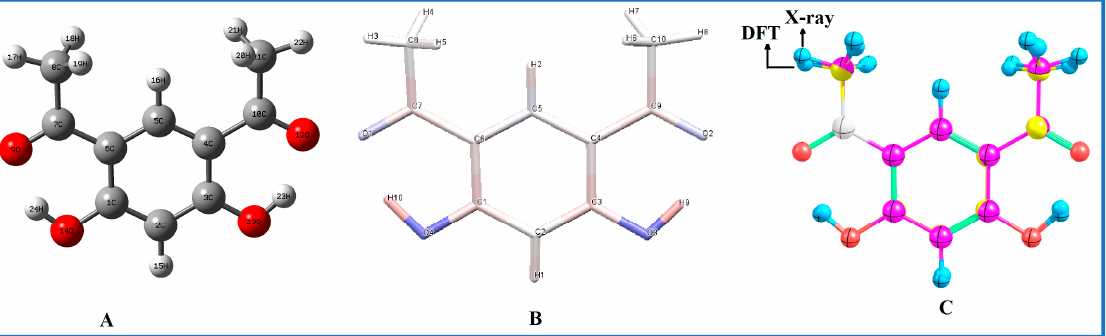
Figure 2. ( A – C ). ( A ) Optimized geometry, ( B ) XRD of 4,6-diacetylresorcinol (1 ) and ( C ) superposition of the optimized structure on the experimental structure atom by atom.